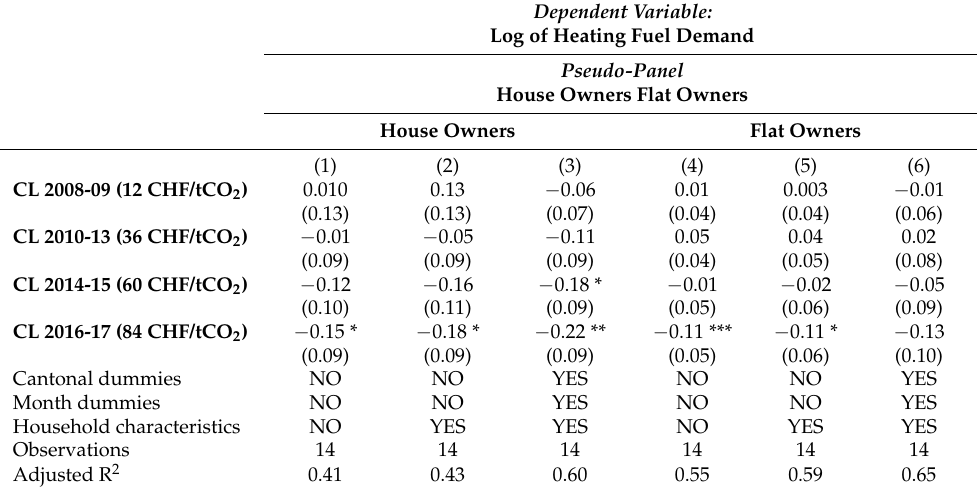
Table 3. Pseudo-panel